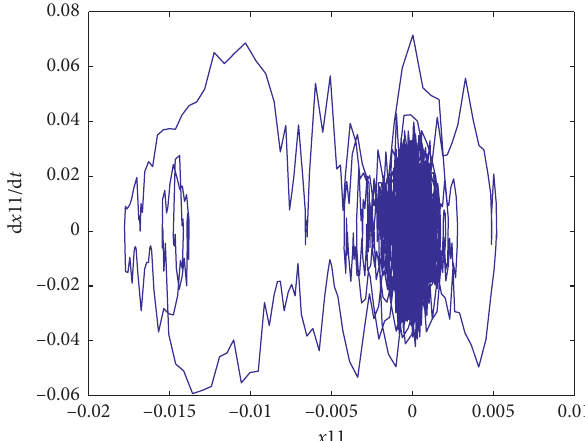
Figure 15: The phase portrait of 11 th story for the active system considering η � 1 and λ �